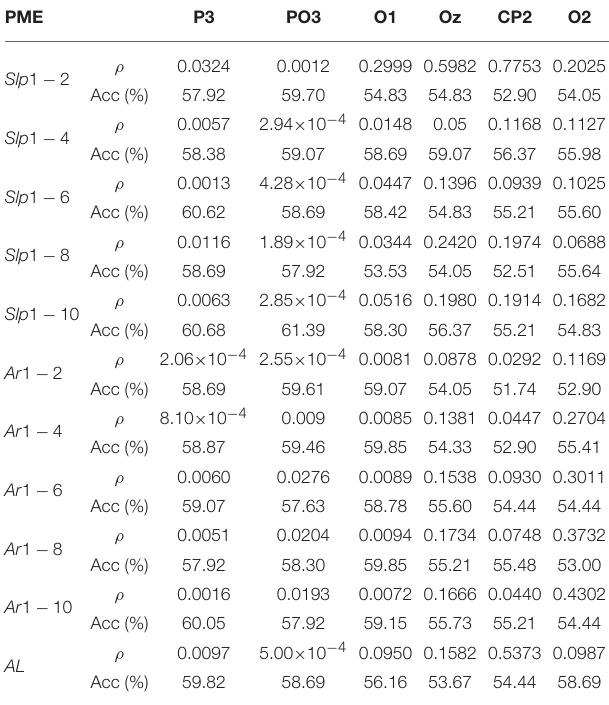
TABLE 3 | Results of ρ and Acc of the PME curve-related